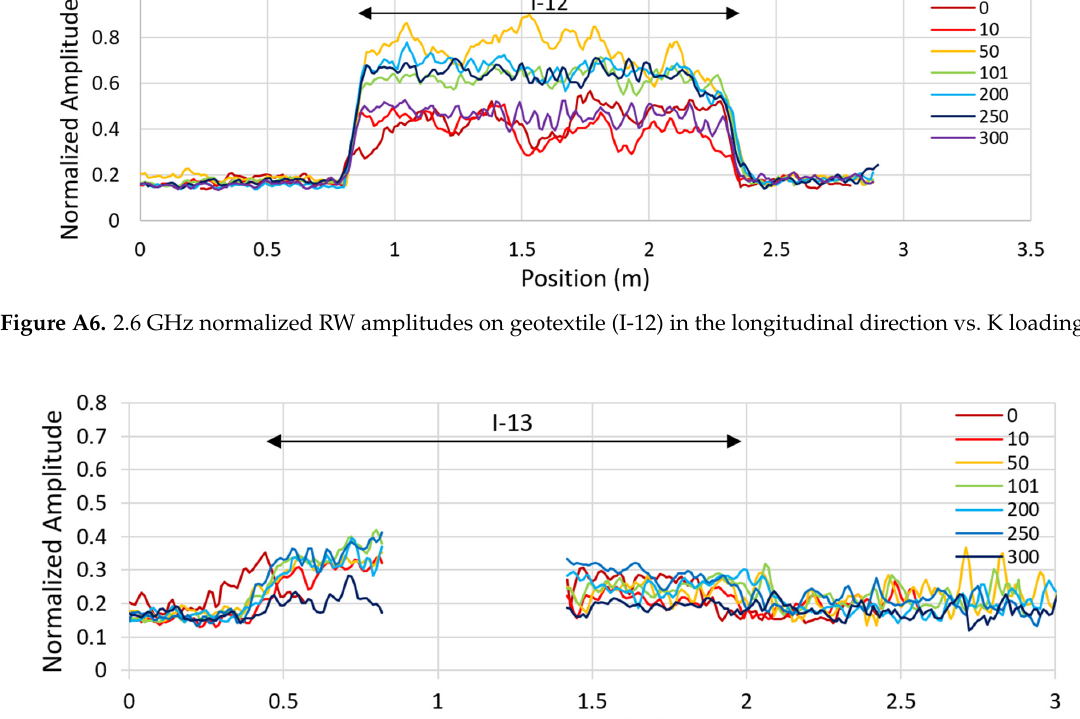
Figure A7. 2.6 GHz normalized RW amplitudes on tack-coat free (I-13) in the long. direction vs. K loadings.